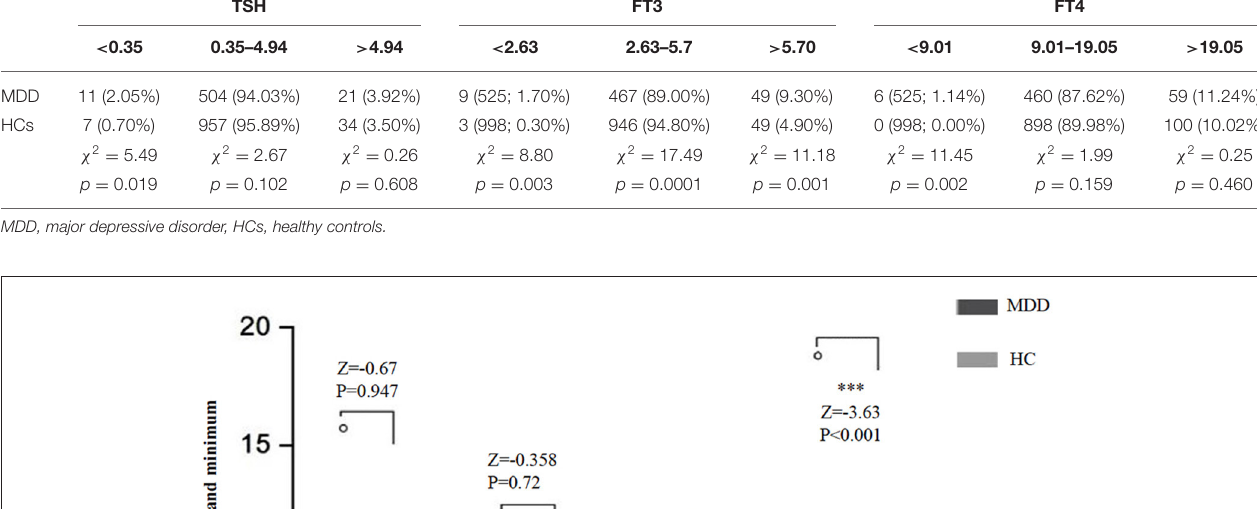
TABLE 3 | The distribution of levels of thyroid hormones within and outside the normal range in the MDD and HC groups. TSH FT3 FT4